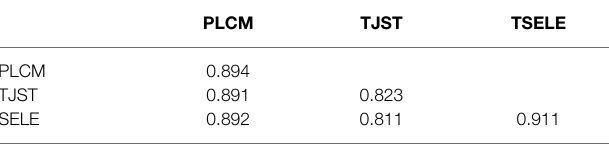
TABLE 3 | Reliability analysis.